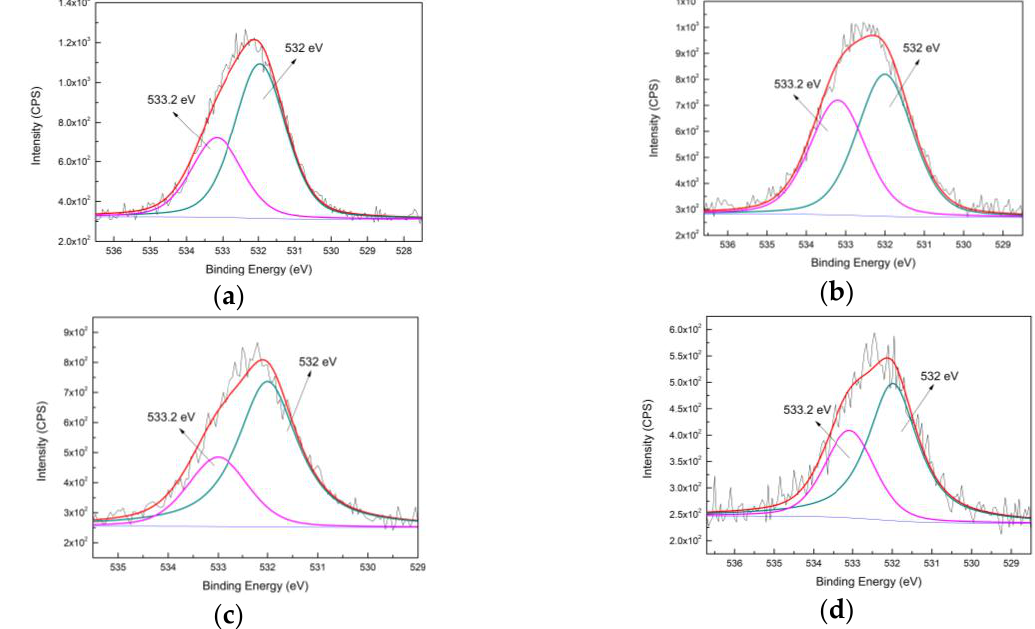
Figure 6. High resolution O 1s spectra of silane deposited zeolite and AuNPs immobilized zeolite: ( a ) APTES deposited zeolite; ( b ) Au@zeolite-APTES; ( c ) MPTES deposited zeolite; ( d ) Au@zeolite- MPTES.